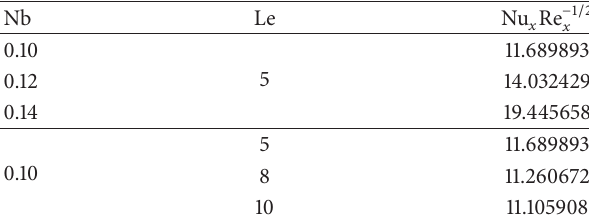
Table 2: The local Nusselt number for different Nb and Le when 𝜆 1 = 1, Pr = 6.8, and Nt =